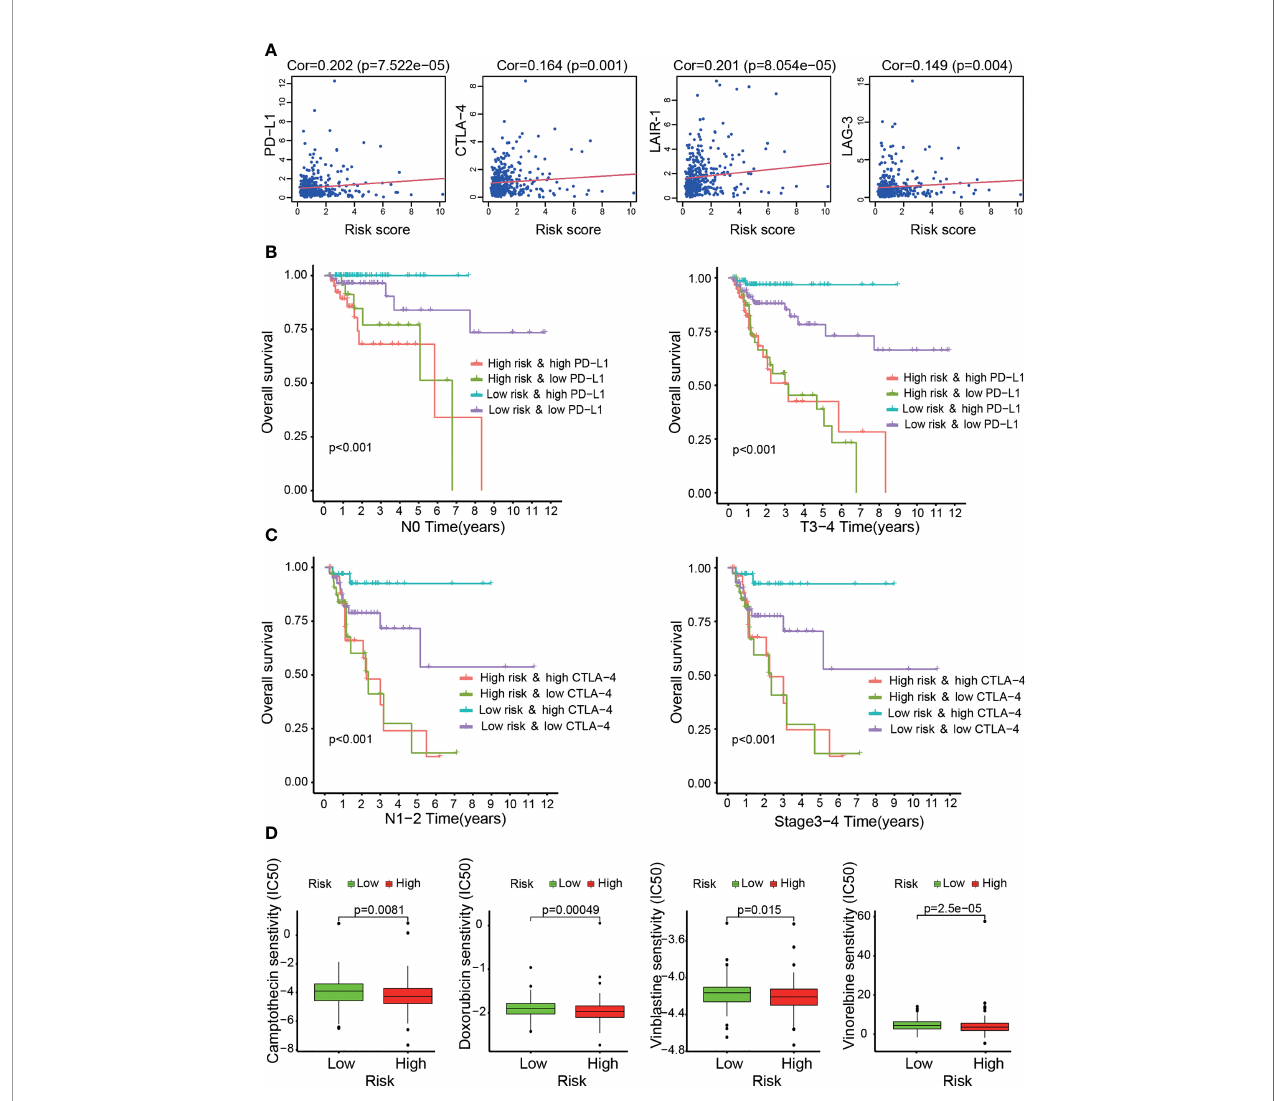
FIGURE 7 | Assessment of immune checkpoint gene expression and its impact on clinical outcome by the risk model. (A) High risk scores were positively correlated with immune checkpoint gene (CTLA-4, LAG-3, LAIR-1 and PD-L1) expression. (B, C) Kaplan – Meier curves for OS among the four groups. Patients strati fi ed by immune checkpoint gene (PD-L1 or CTLA-4) expression and risk score potentially had different outcomes. (D) The risk model acted as a predictor for chemosensitivity, as patients with high risk scores tended to have lower IC50 values for chemotherapy drugs, such as doxorubicin, camptothecin, vinblastine and